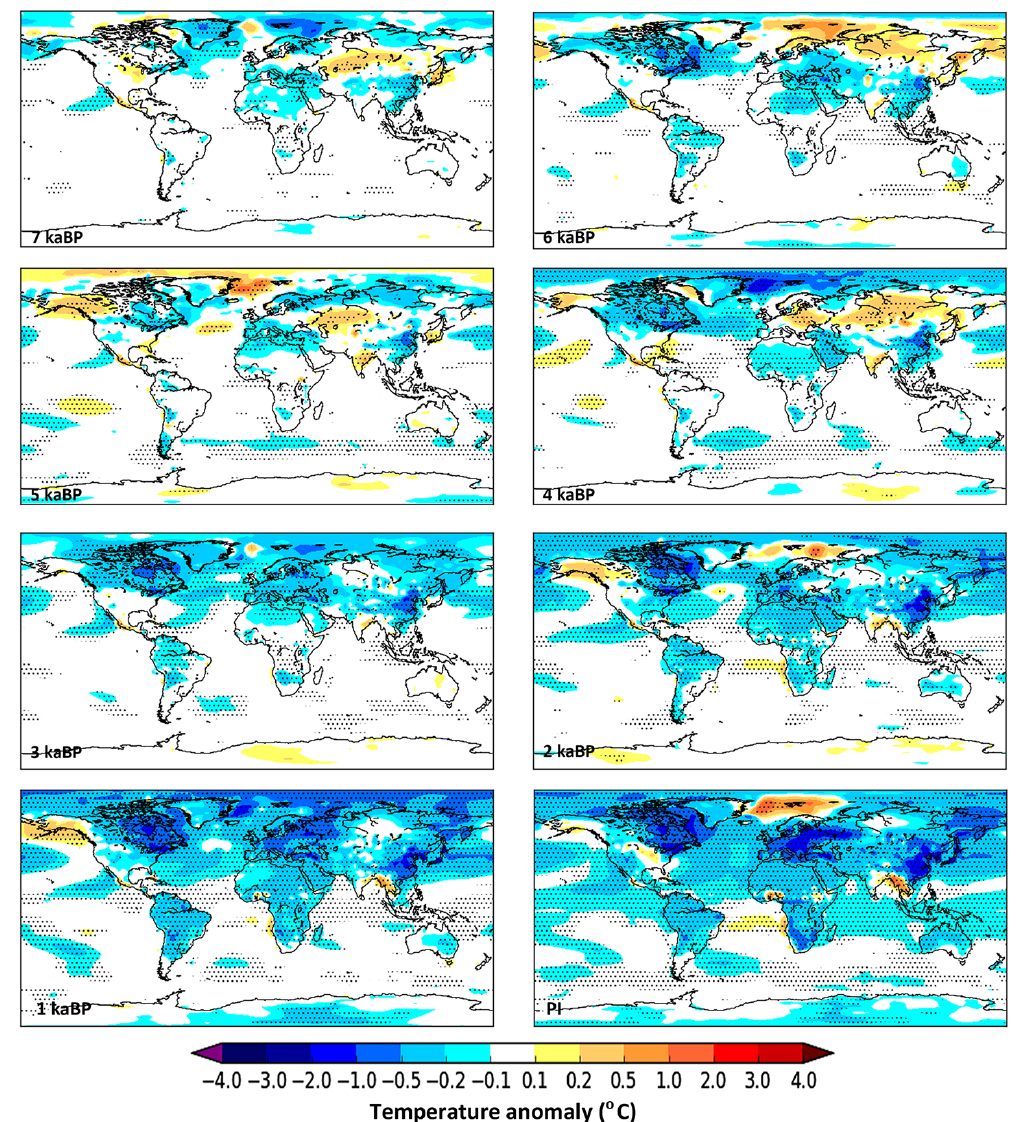
Figure 3. DJF temperature anomalies ( ◦ C) for KK10 minus control at time slices from the late pre-industrial period (1850CE) to 7kaBP. The stippling indicates grid boxes where the anomalies are significant at the 95% level using Wilcoxon rank sum statistical